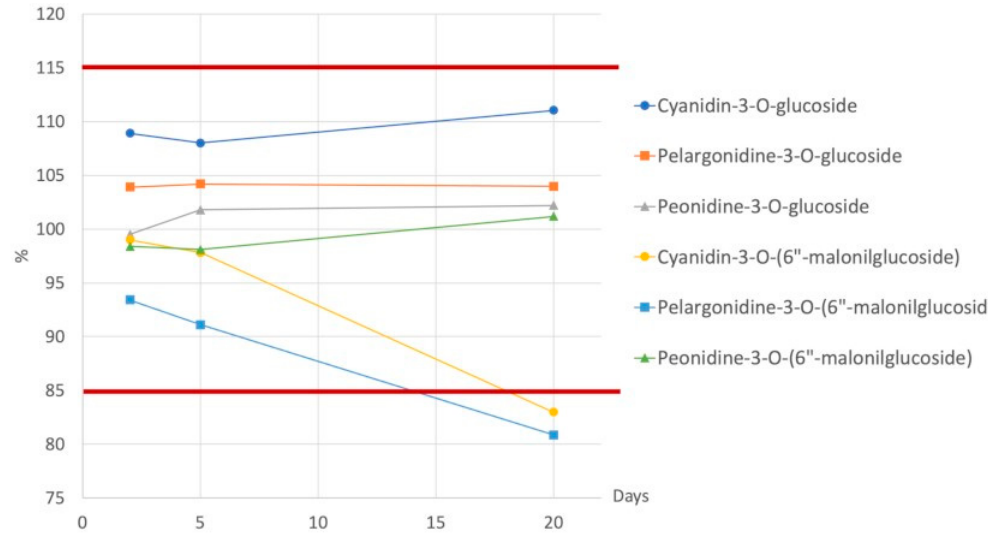
Figure 5. Percentage of variation of anthocyanins evaluated maintaining samples at − 20° for 2, 5, and 20 days.